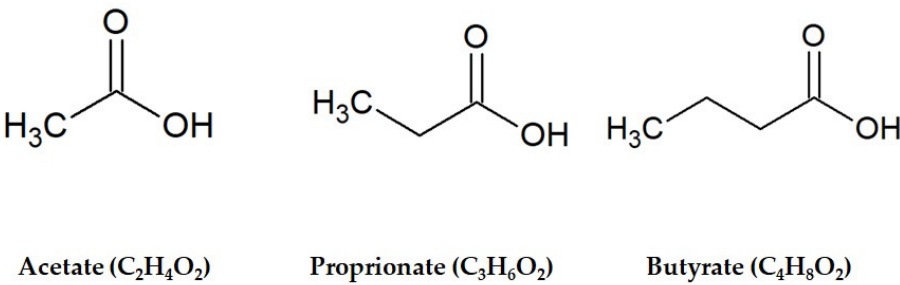
Figure 1. Chemical structures of the main short-chain fatty acids.